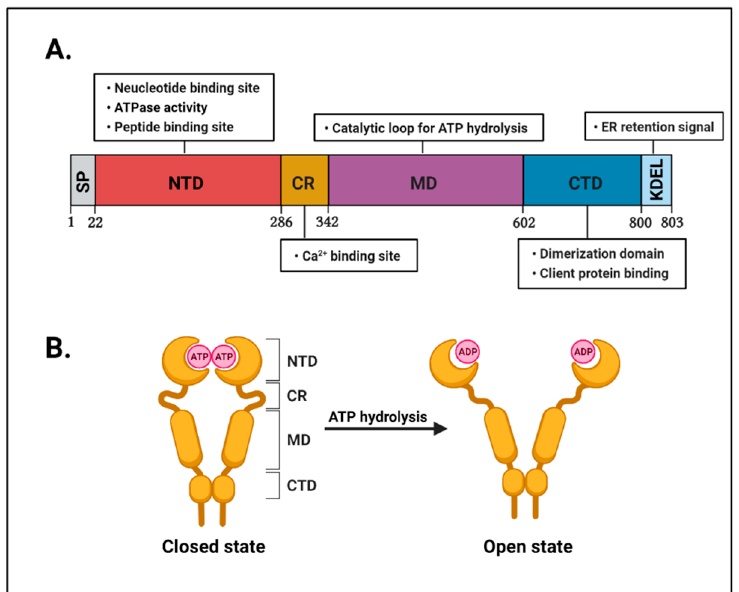
Figure 1. Structural feature of GRP94. ( A ) A schematic representation of the domain organization of human GRP94. The first 21 sequences are signal peptide sequences (gray) displayed as SP. Next, the N-terminal domain (NTD; red) plays an important role in ATPase activity and contains a nucleotide and peptide binding site. The charged linker region (CR) contains a calcium-binding site (orange). The middle domain (MD; purple) contains a catalytic loop for ATP hydrolysis. The C-terminal domain (CTD; blue) plays an important role in dimerization and client protein binding. KDEL (light blue), the C-terminal tetrapeptide of GRP94, serves as the endoplasmic reticulum (ER) retention/retrieval ligand for the KDEL receptor. ( B ) Schematic representation of the GRP94 structure. The conformational change in GRP94 occurs through ATP binding and ATP hydrolysis. GRP94 changes its state from “closed” to “open” through ATP hydrolysis.